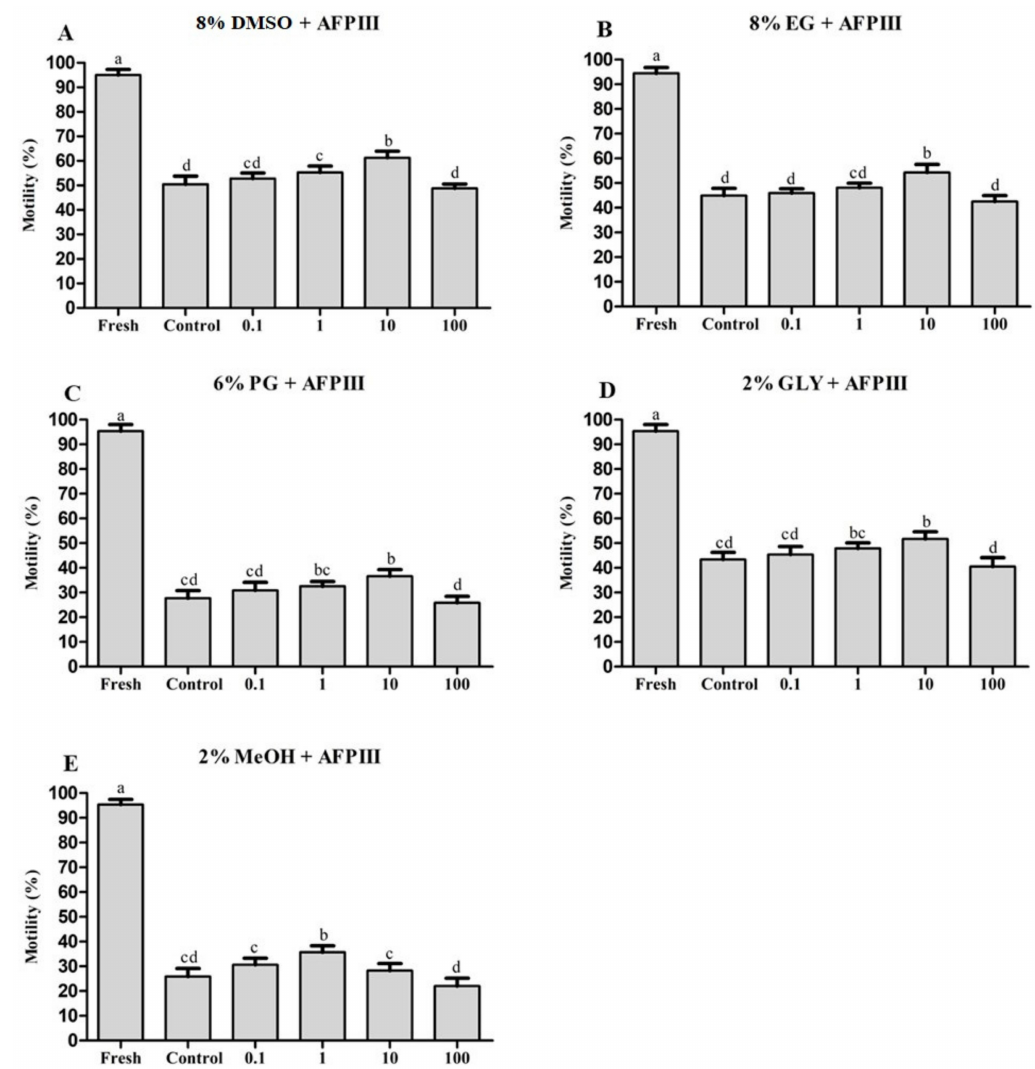
Figure 1. Post-thaw motility of sperm cryopreserved with antifreeze protein III (AFPIII) at different concentrations (0.1, 1, 10, and 100 µ g/mL). Significantly different levels ( p < 0.05) are denoted by different letters. ( A ) Combined effects of AFPIII with 8% dimethyl sulfoxide (DMSO) at different concentrations. ( B ) Combined effects of AFPIII with 8% ethylene glycol (EG) at different concentrations. ( C ) Combined effects of AFPIII with 6% propylene glycol (PG) at different concentrations. ( D ) Combined effects of AFPIII with 2% glycerol (GLY) at different concentrations. ( E ) Combined effects of AFPIII with 2% MeOH at different